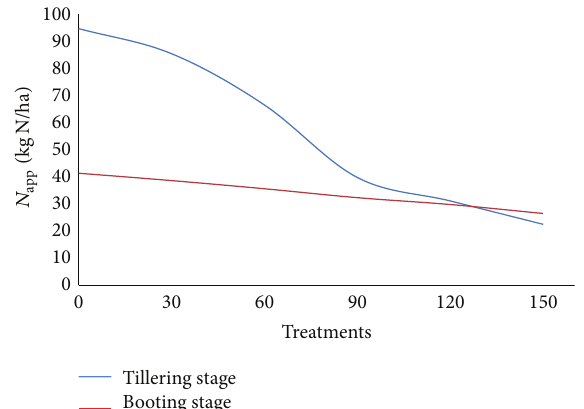
Figure 17: N-application (N app rate) as a function of different N- treatments using N-sensor algorithm during tillering and booting